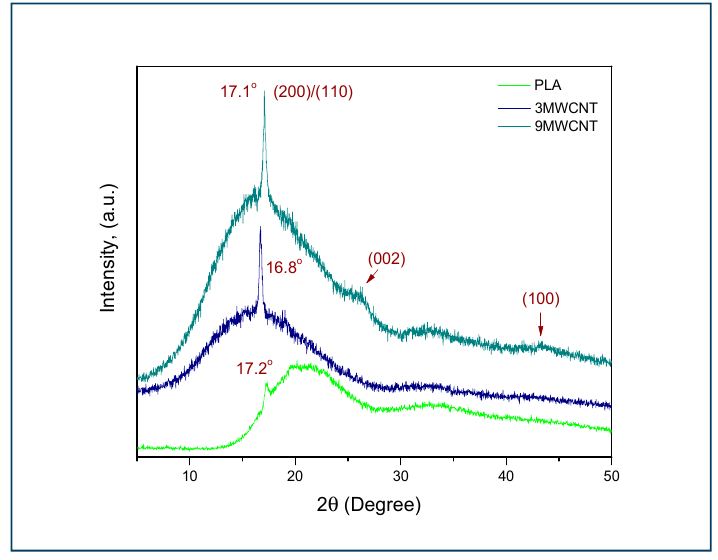
Figure 7. X–ray diffraction of nanocomposites with rising carbon nanotubes concentration and neat PLA as a reference.